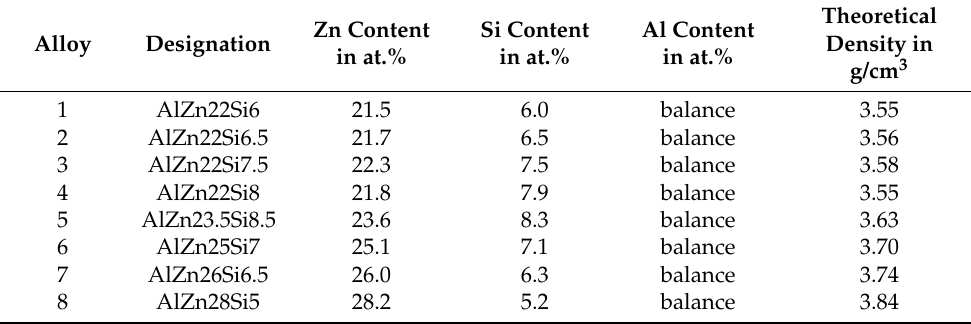
Table 3. Actual chemical compositions of the low-melting aluminum